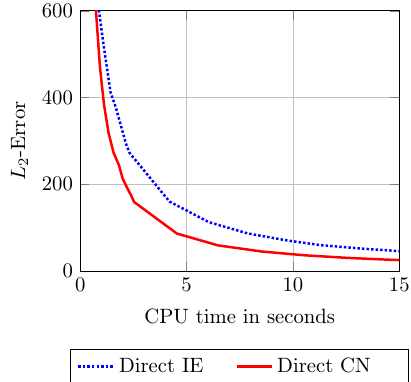
Figure A2. Results of the two-dimensional GES experiment without source: comparison of the L 2 - error and corresponding CPU time between direct IE and direct CN at t F = 2.609 The reference solution is computed using EE. The CN scheme clearly outperforms the IE method.